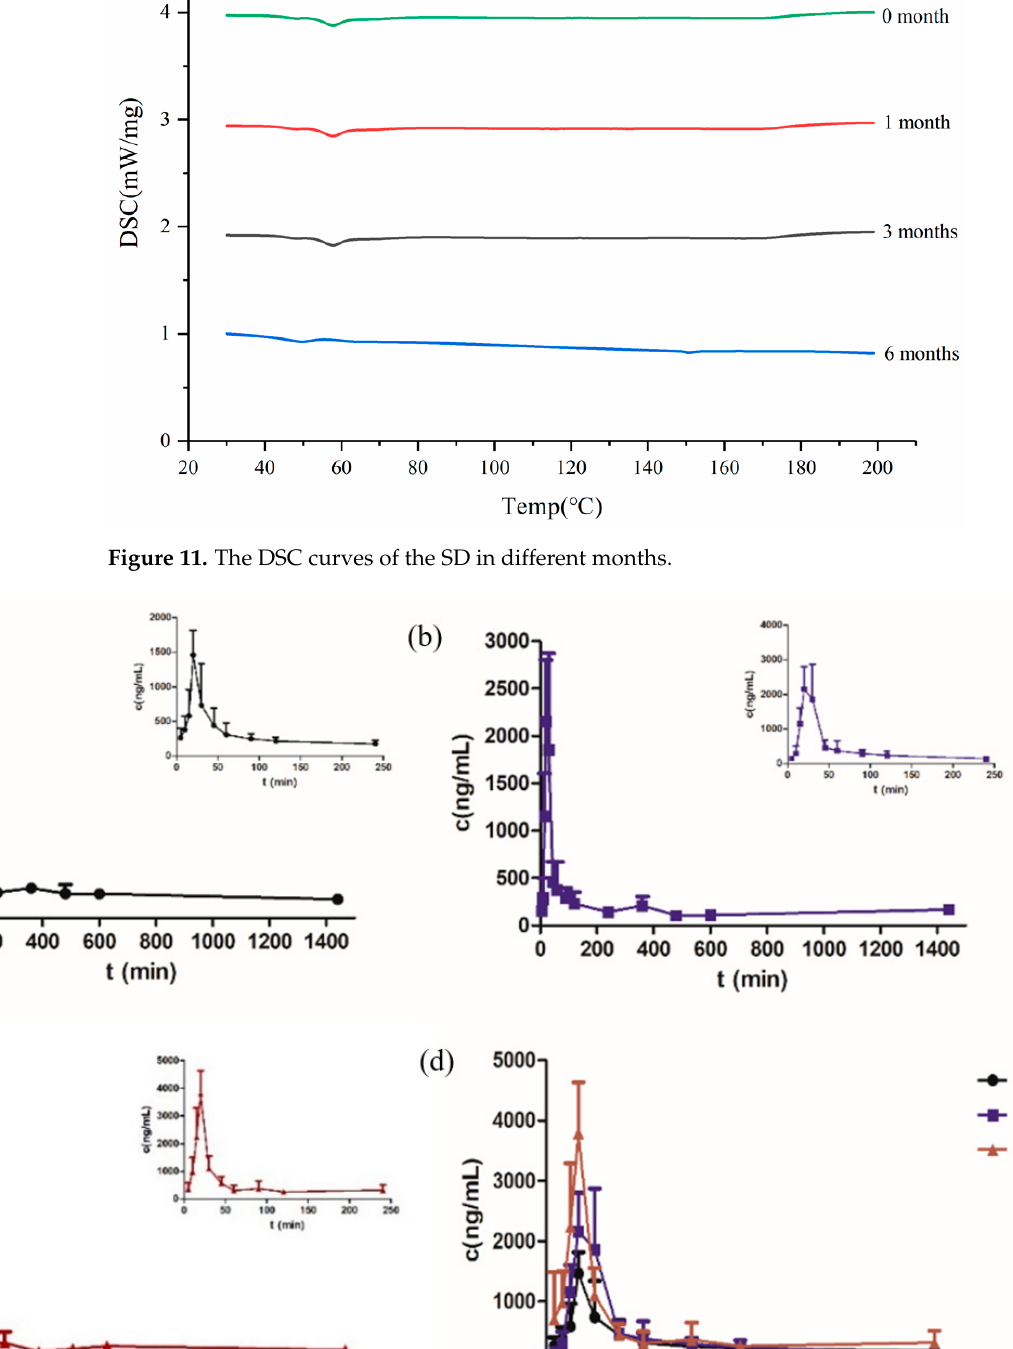
Figure 12. The plasma concentration-time curves of Cur in rats after oral administration of Cur ( a ), PM ( b ), the SD ( c ) and Cur, PM, SD ( d ) (n = 5, mean ± SD).